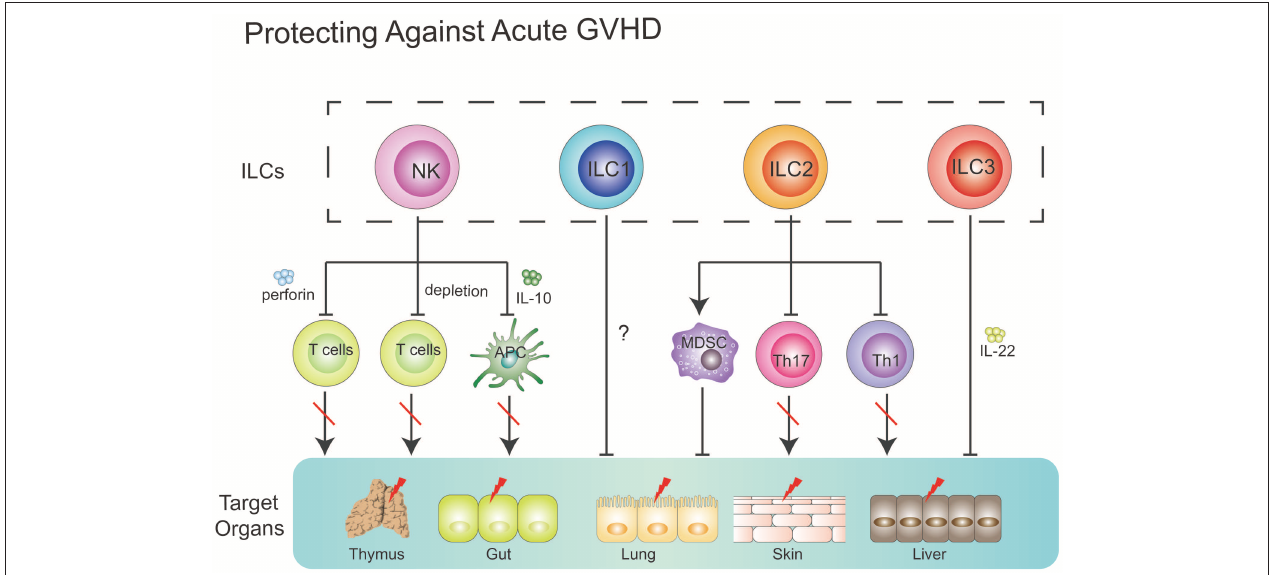
FIGURE 3 | Role of ILCs in GVHD. NK cells can suppress GVHD via three main mechanisms, including direct lysing of activated T cells, indirect inhibition of T cell proliferation through depleting host APCs and production of suppressive cytokines, such as IL-10. ILC1 cells might migrate to the skin and alleviate cutaneous GVHD. Intravenous infusion of donor-derived ILC2 cells into ongoing GVHD mice can reduce the production of Th1 and Th17 cells while increasing the number of MDSCs via secreting IL-13. ILC3 cells play a protective role in GVHD. Recipient-derived ILC3 cells can alleviate pretreatment regimen-induced GI tract lesion via secretion of IL-22. Furthermore, these ILC3 cells can improve thymopoiesis in the hosts after